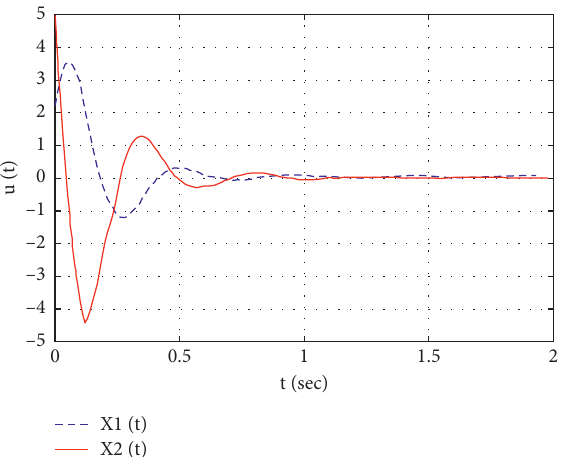
Figure 3: Time response of the system